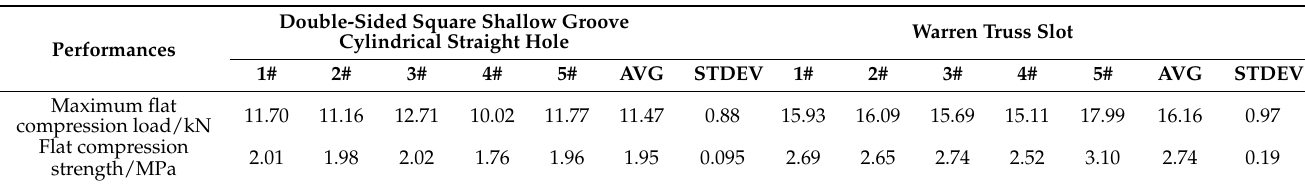
Figure 23. Load–displacement curves of the slot resin-reinforced sandwich composites ( a ) and ( b ) by flat compression test. Table 5. Flat compression test results of the slot resin-reinforced sandwich composite core test samples.